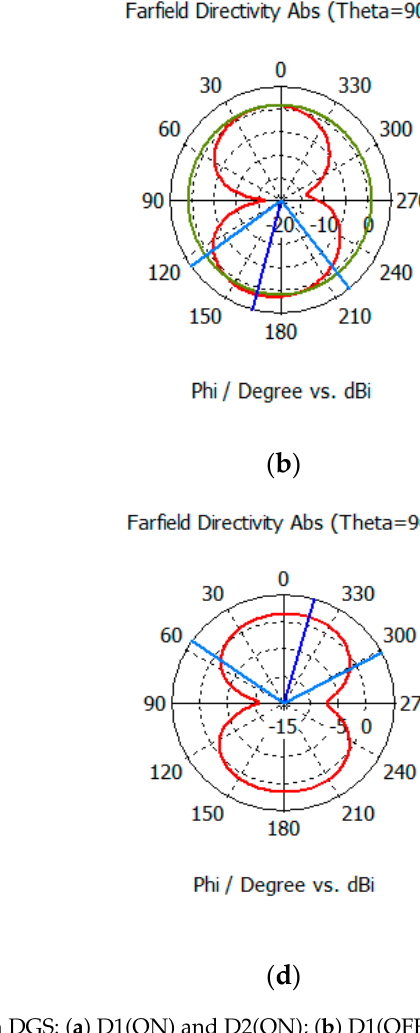
Figure 11. Radiation pattern at 4 GHz with DGS: ( a ) D1(ON) and D2(ON); ( b ) D1(OFF) and D2(ON); ( c ) D1(ON) and D2(OFF); ( d ) D1(OFF) and D2(OFF).